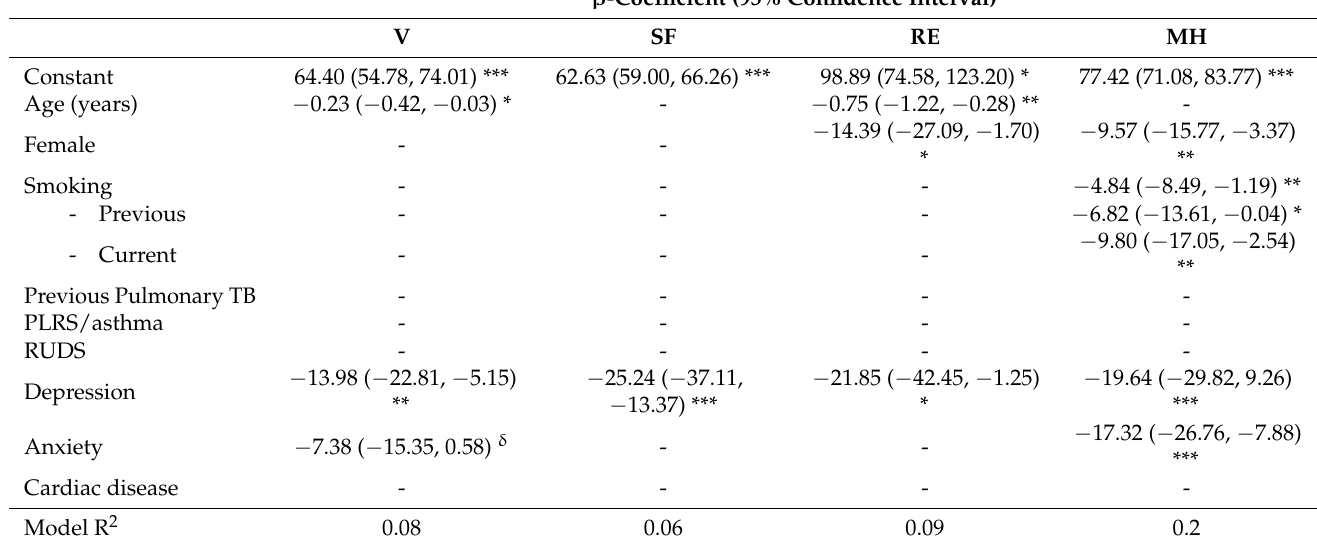
Table 4. Significant determinants of health-related quality of life according to SF-36 subscale scores for mental health domains of Macassar residents ( n = 246) 6 years after the fire incident using multivariate linear regression models.